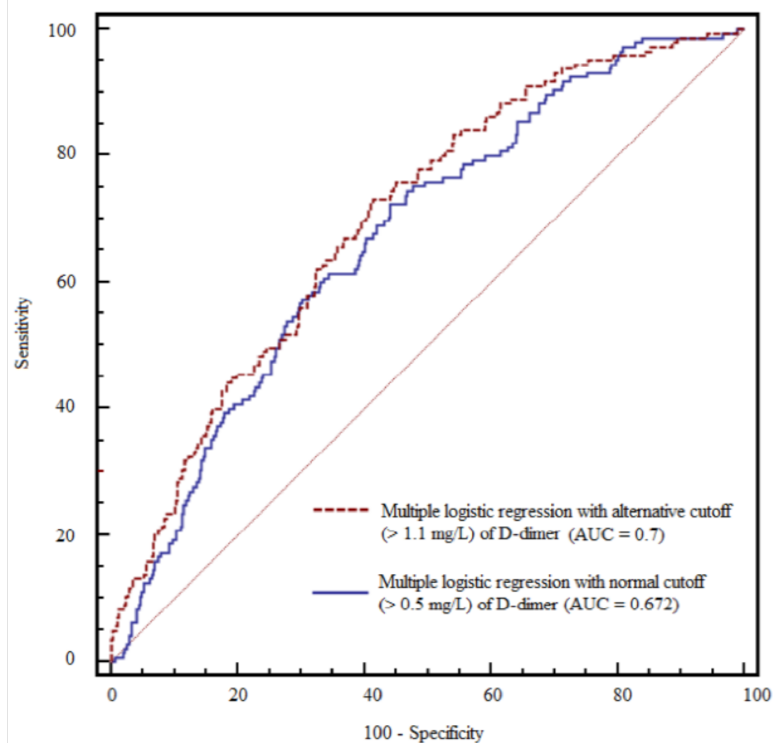
Figure 1. Comparison of the area under the receiver operating characteristic (ROC) curve (AUC) between multiple logistic regression models with the normal (0.5 mg/L) and alternative (1.1 mg/L) D-dimer cutoff levels.